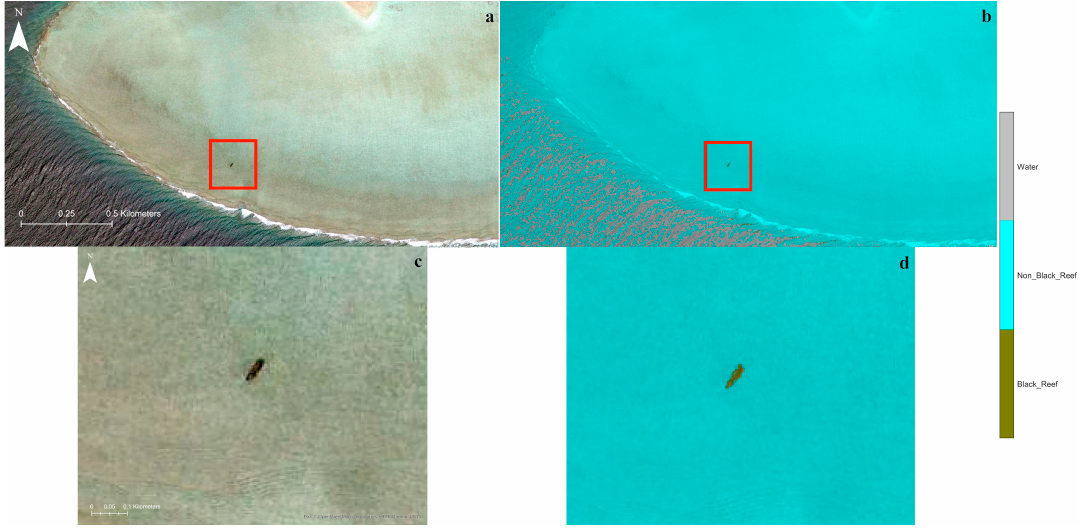
Figure 13. ( a ) Google Earth image of the St Brandon reef (Google Earth Pro, 2005); the red rectangle shows the location of a shipwreck, ( b ) segmented image, ( c ) zoomed part of the Google Earth image focusing on the shipwreck, ( d ) the corresponding zoomed part of the segmented